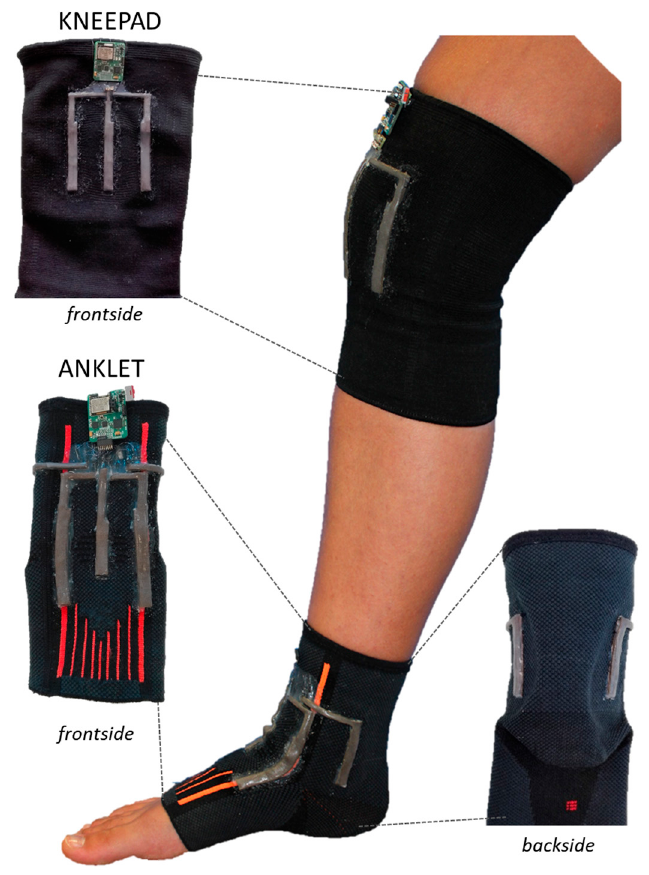
Figure 4. Prototypes of knee and ankle modules each integrating several sensors connected to one read out electronic system that communicates with an external board by a RF module.